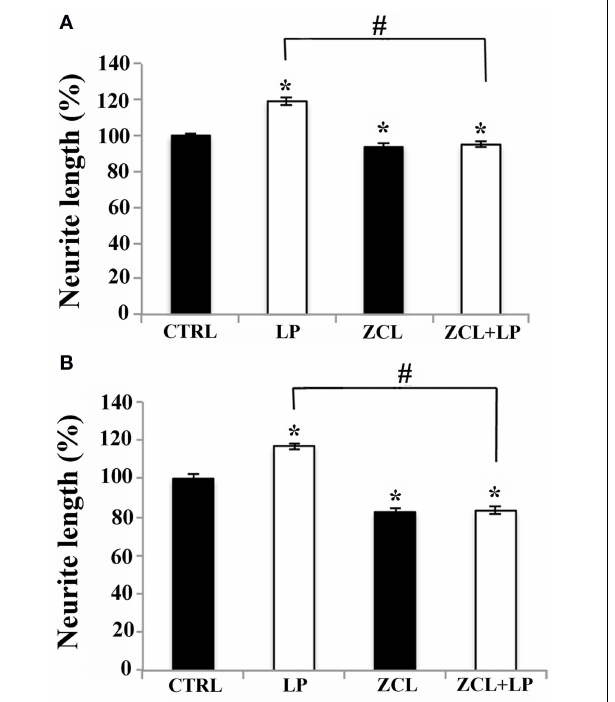
FIGURE 4 | Cdc42 signaling pathway is required for neurite elongation induced by 5-HT7R stimulation. (A) Striatal and (B) cortical neurons were treated for 2h either with the 5-HT7R selective agonist LP-211 (LP, 100nM), or with the selective Cdc42 inhibitor ZCL (50 µ M), or with a combination of the two. The graphs show the neurite length expressed as percentage of values measured in the corresponding vehicle-treated cultures (CTRL, set to 100%). The bars represent means ± SEM from randomly selected fields for each cell culture condition ( n = 6 ). Asterisk (*): values significantly different from CTRL by One Way ANOVA followed by Dunnett post-hoc test ( p < 0 . 05 ). Number sign (#): values significantly different from each other by One Way ANOVA followed by Tuckey post-hoc test ( p < 0 . 05